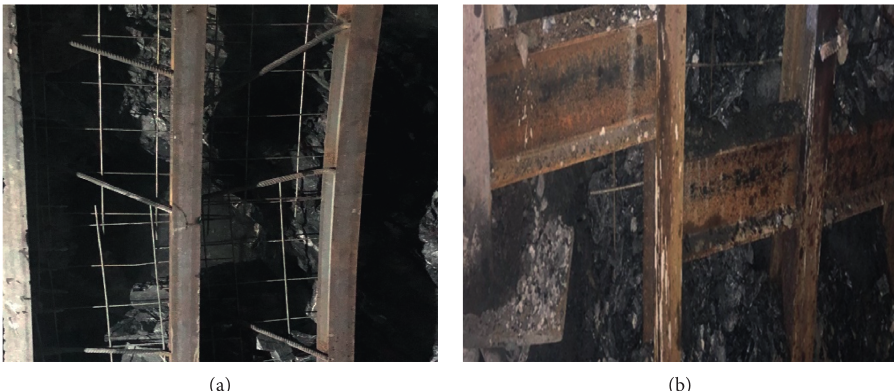
Figure 13: Common longitudinal connection methods of the steel arch: (a) longitudinal connection of the rebar; (b) longitudinal connection of the channel steel.